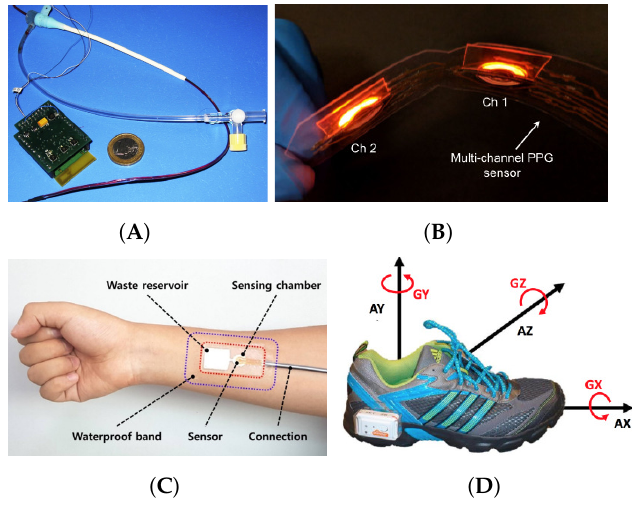
Figure 4. Wearable sensors. ( A ) Zigbee to monitor physiological parameters [54] (Reproduced with permission from Elsevier). ( B ) Optoelectronic wrist sensor for health monitoring [58] (Licensed under (CC BY 4.0)). ( C ) Stretchable electrochemical sensor for glucose monitoring [69] (Reproduced with permission from ACS). ( D ) On-shoe wearable sensor for gait analysis in Parkinson’s Disease [64] (Licensed under (CC BY